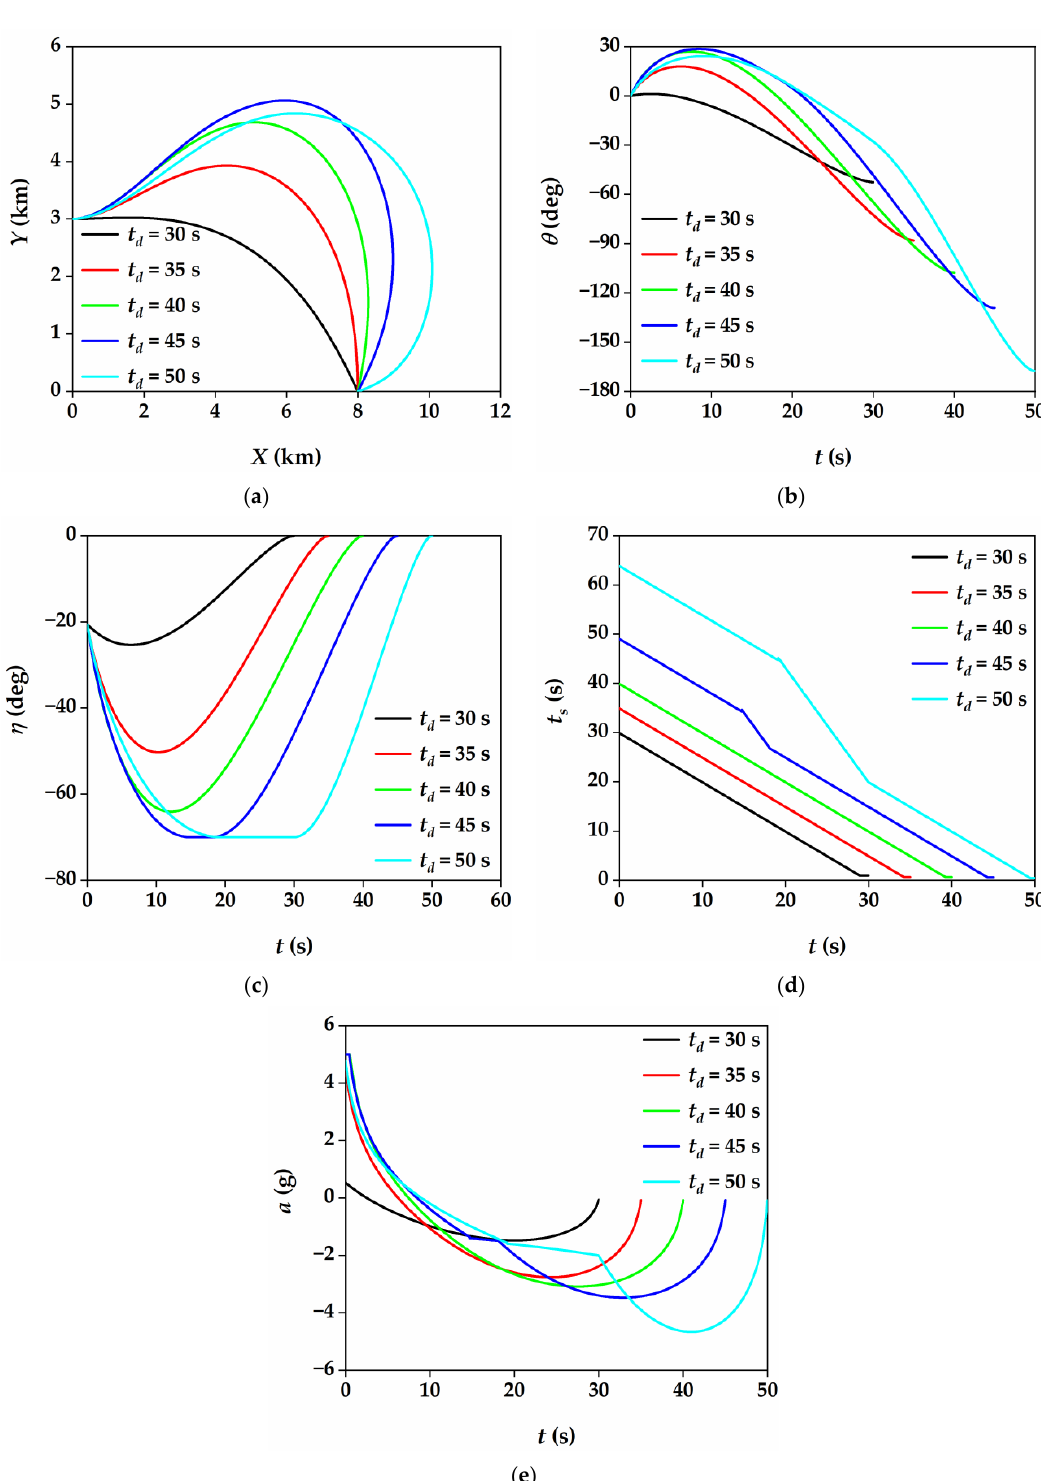
Figure 4. Simulation results of (36) under different desired impact times. ( a ) Missile flight trajectory ; ( b ) Flight path angle ; ( c ) Lead angle ; ( d ) Profile of coefficient t s ; ( e ) Missile acceleration.